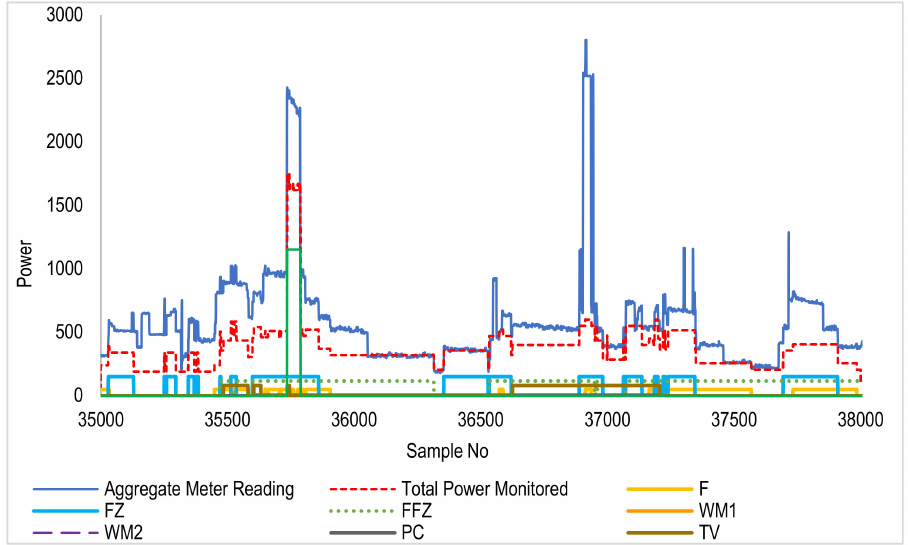
Figure 7. Aggregate and clustered REFIT data (samples: 35,000 to 38,000 window). As indicated in the legend, each device’s disaggregated profile is shown in a different color. The red plot is the sum of disaggregated devices’ energy. It is seen that the trend of sum (red) follows the aggregate (blue) at each instant showing the effectiveness of the technique.